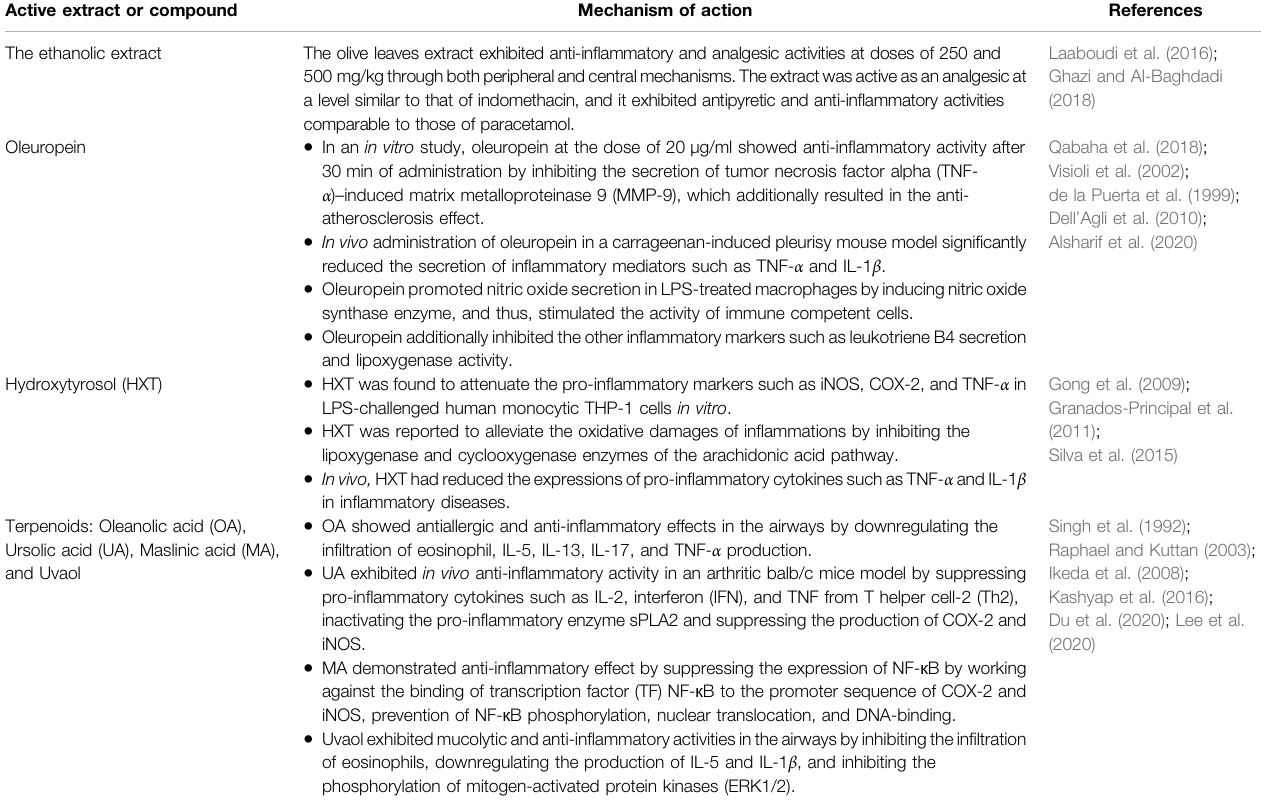
TABLE 2 | Anti-in fl ammatory, antipyretic, and analgesic activities of olive leaf compounds against SARS-CoV-2. Active extract or